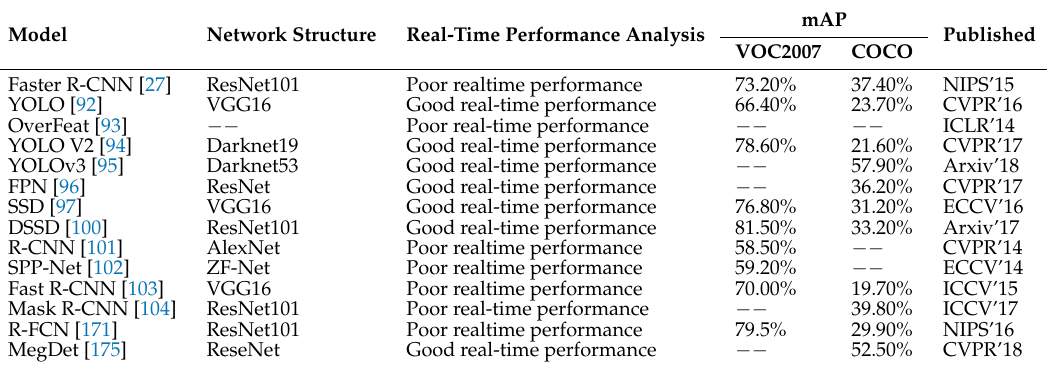
Table 7. Performance comparison of deep-learning object detection